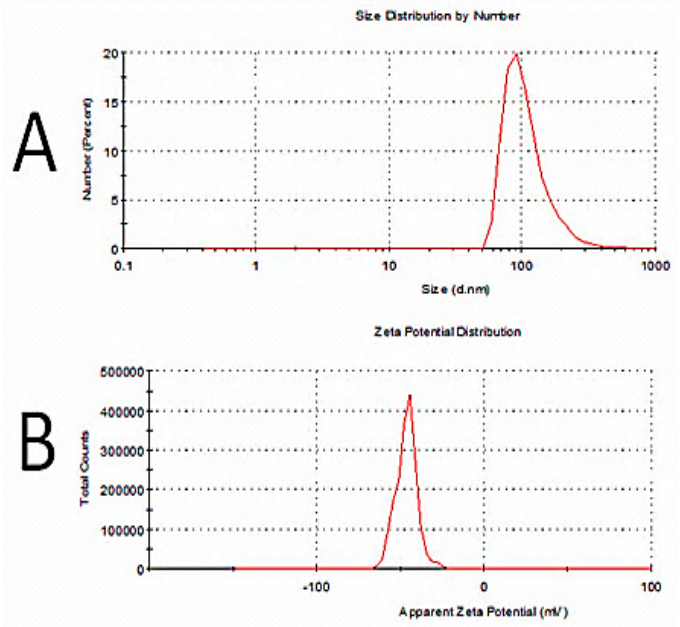
Figure 3. DLS of CEONE ( A ) and zeta potential of CEONE (peak at—46.3 mV) ( B ).